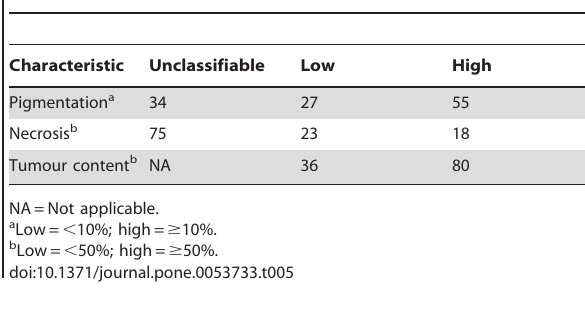
Table 5. Distribution of pathological